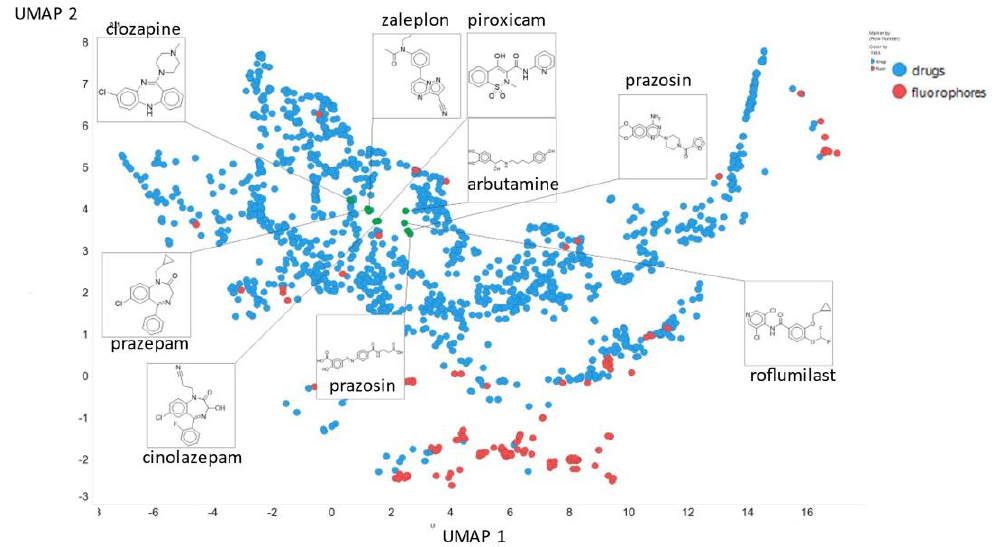
Figure 20. Positions of chlorpromazine, prazosin and some other molecules in UMAP space when the NT-Xent temperature factor is 0.1.